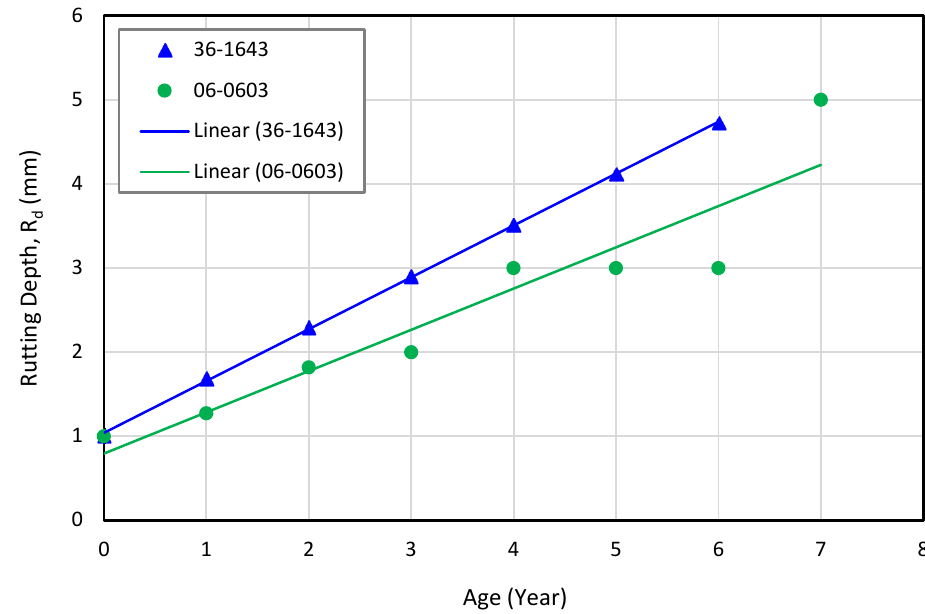
Figure 13. Rutting progression on the LTPP test sections with high structural capacity.